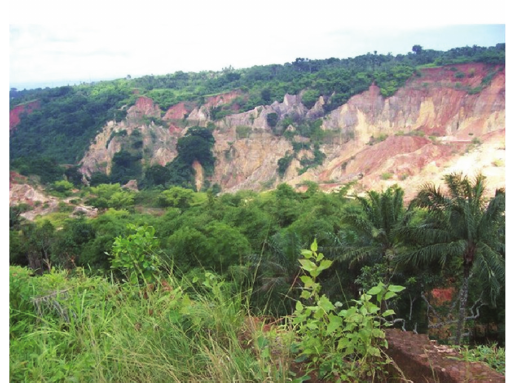
Figure 2: A gullied farmland in southeastern Nigeria, after Igwe